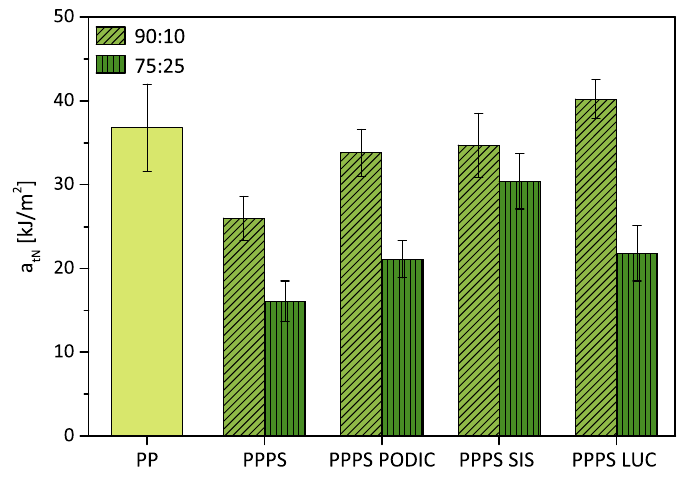
Figure 13. Tensile impact strength of virgin PP and PP–PS blends.